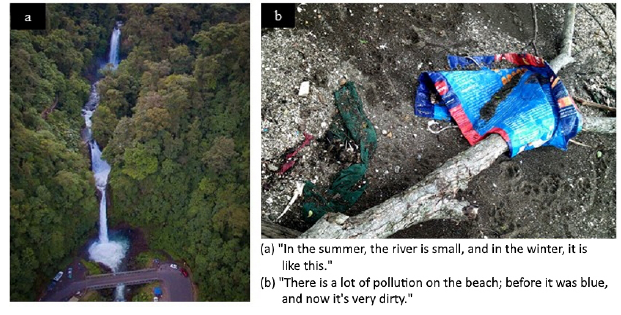
Fig. 7 . Photographic responses to the question, "How has